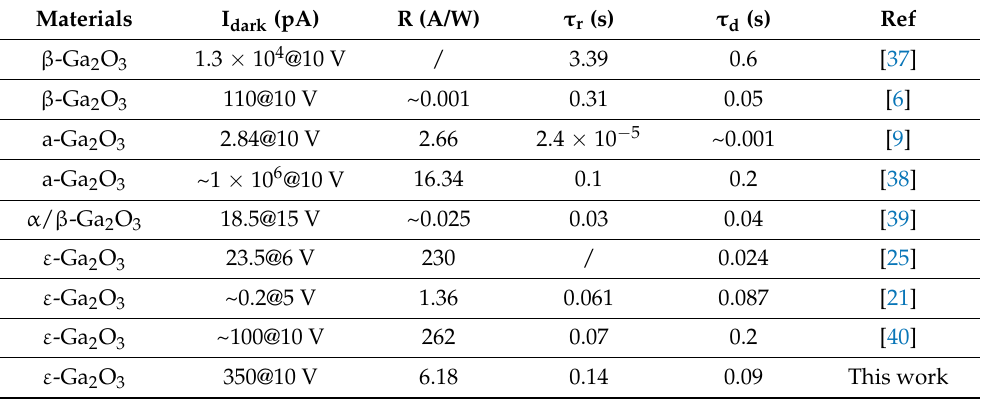
Figure 4. ( a ) Time-dependent curve of the ε-Ga 2 O 3 thin-film solar-blind ultraviolet photodetector with external bias under 254 nm illumination of 1000 μW/cm 2 ; ( b ) time-dependent photoresponse curves of the device under 254 nm illumination and different light intensities; ( c ) comparison diagram of the photoresponse of the device before and after one month. Table 1. Comparison of the characteristic parameters of previous MSM-type Ga 2 O 3 film